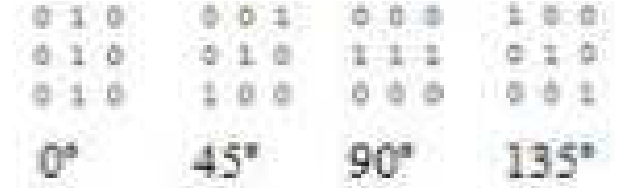
Figure 2 - Structuring Element line